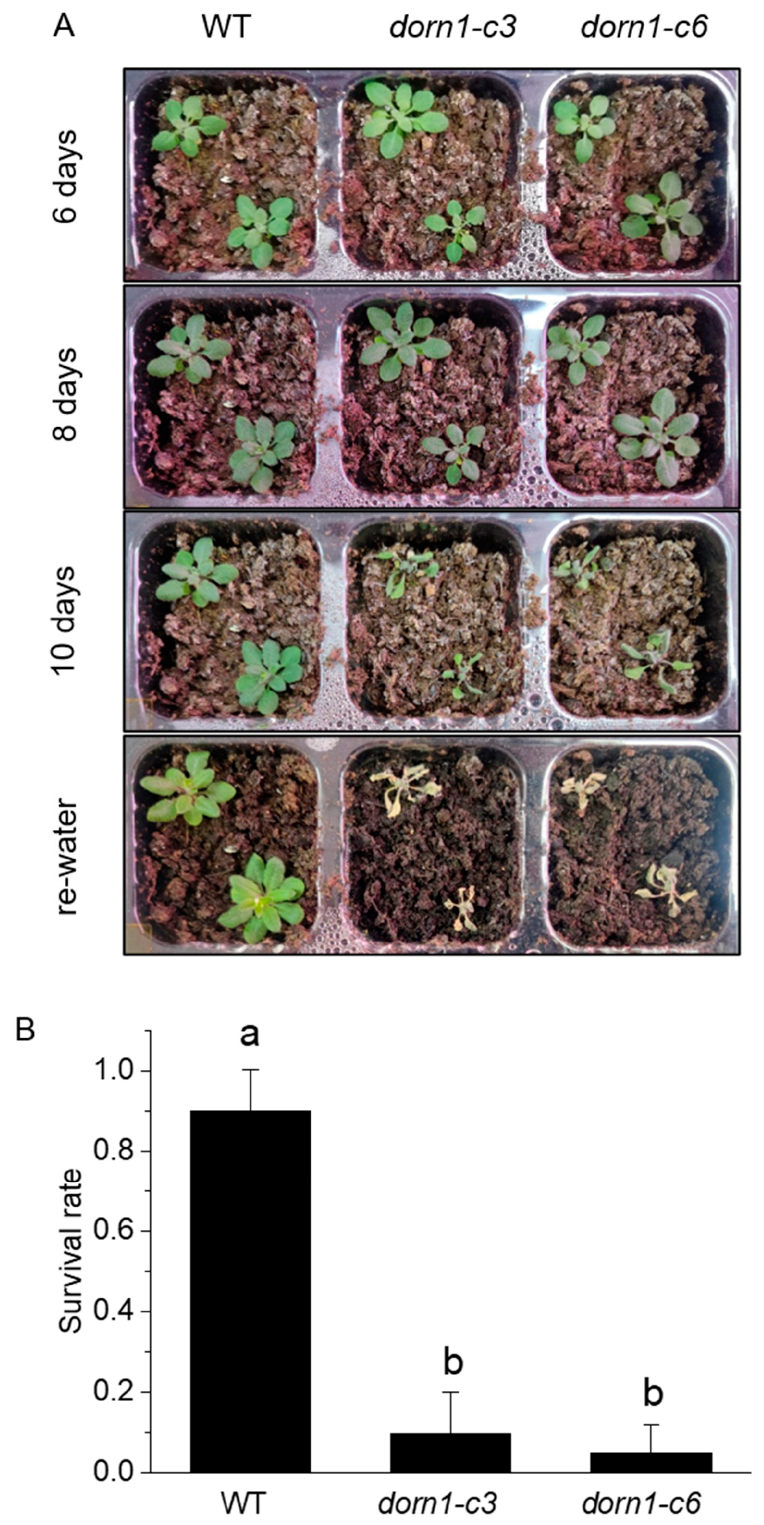
Figure 2. Phenotypic analysis of drought tolerance in the dorn1 mutant. ( A ) Phenotype of 7-day seedlings treated with different periods of drought and rehydration. ( B ) The survival rate of different plants after rehydration, different letters indicate significant differences ( p < 0.05) using ANOVA analysis. Each data point represents the average survival rate of ~15 seedlings of three duplicate experiments, and error bars represent the standard deviation (SD).